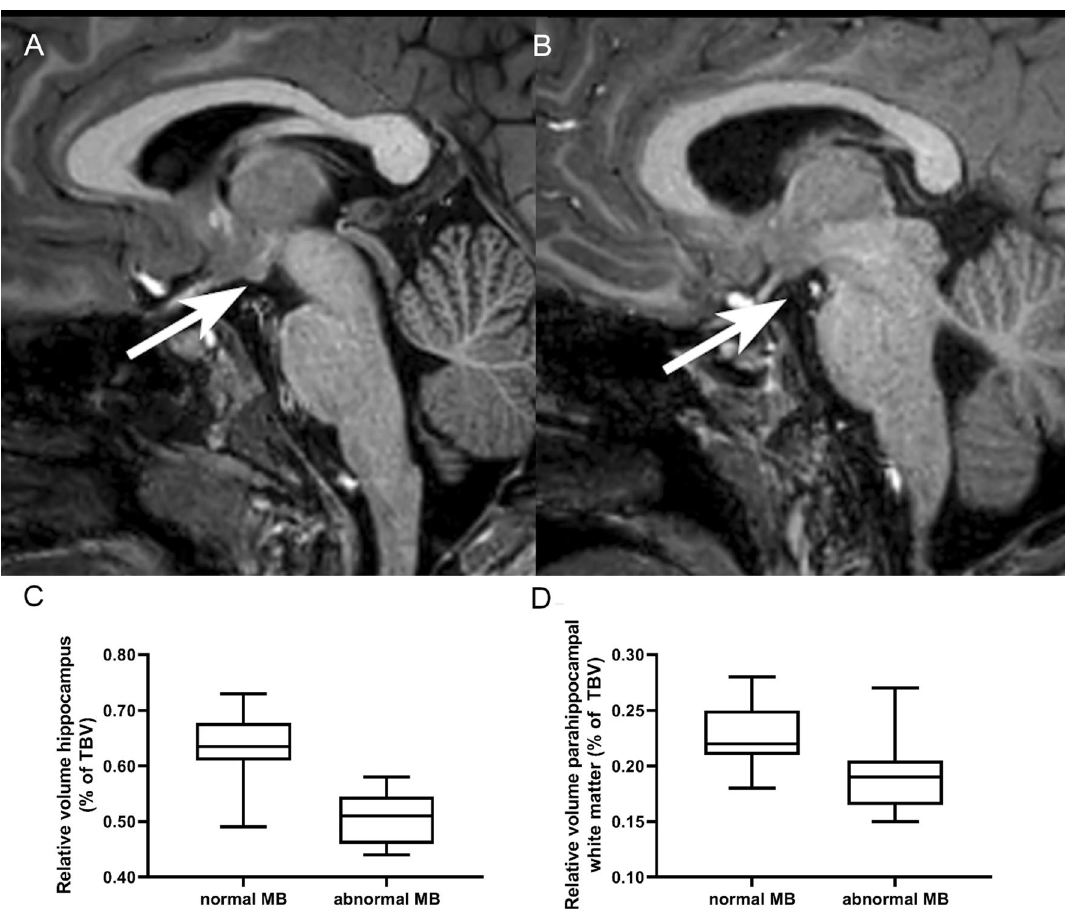
Figure 1. Example of normal MB ( A ) and atrophy of the MB ( B ) at 10 years of age. Differences in relative hippocampal volume ( C ) and parahippocampal volume ( D ) between children with normal MB and atrophy of the MB at 10 years of